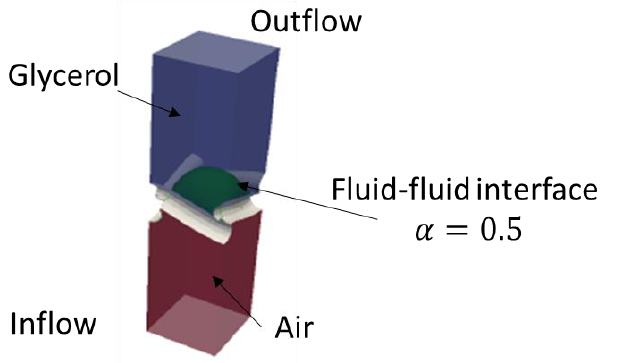
Figure 5. Visualization of the computational domain. Red corresponds to the gas, blue corresponds to the wettable viscous fluid, white corresponds to fibers, and green is the iso-surface defined by the condition 𝛼 = 0.5.